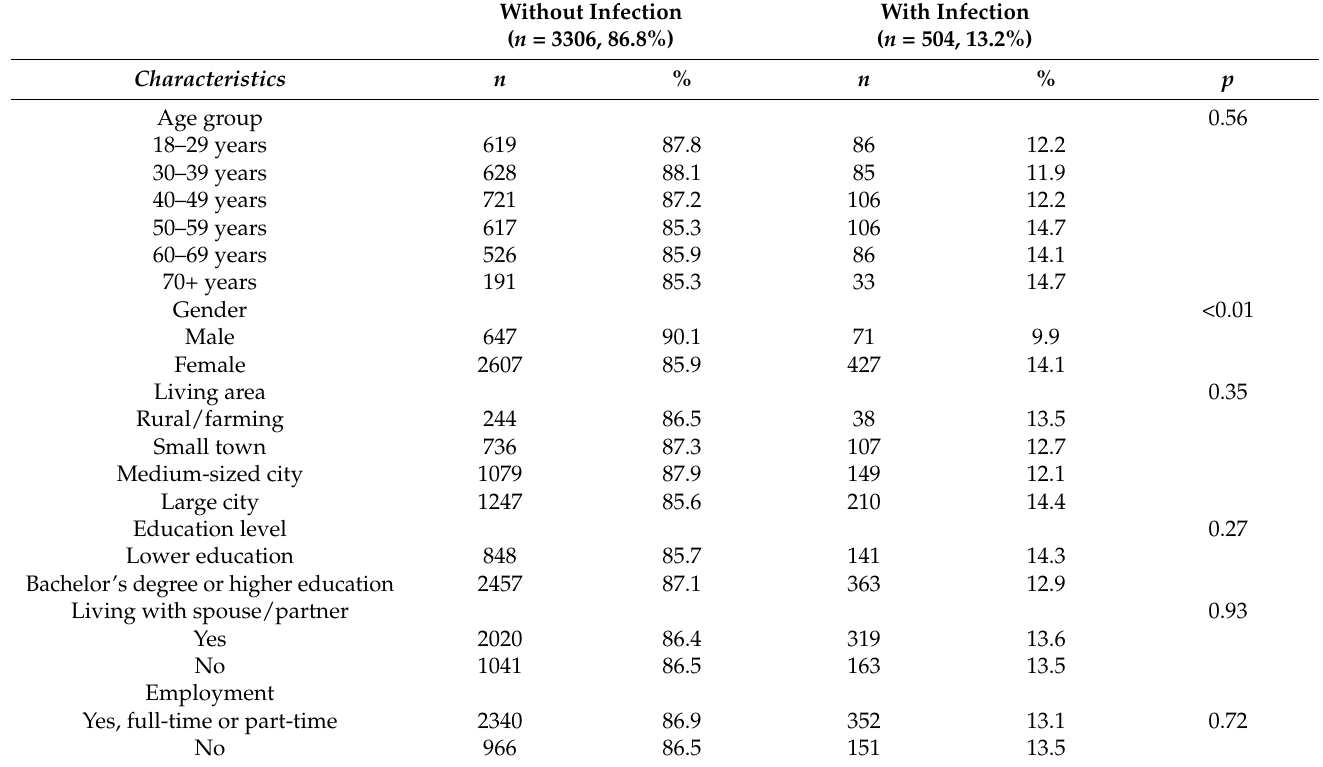
Table 1. Sociodemographic characteristics among individuals with and without COVID-19 infection.